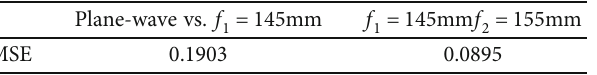
Table 3: Comparison of reconstruction errors between the two di ff raction modes.